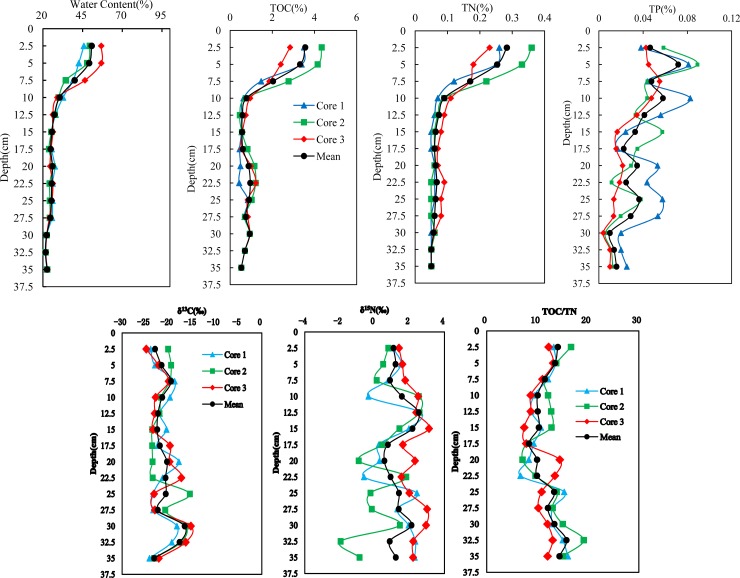
Vertical distribution profiles of water content, TOC, TN, TP, δ13C, δ15N, and TOC/TN.